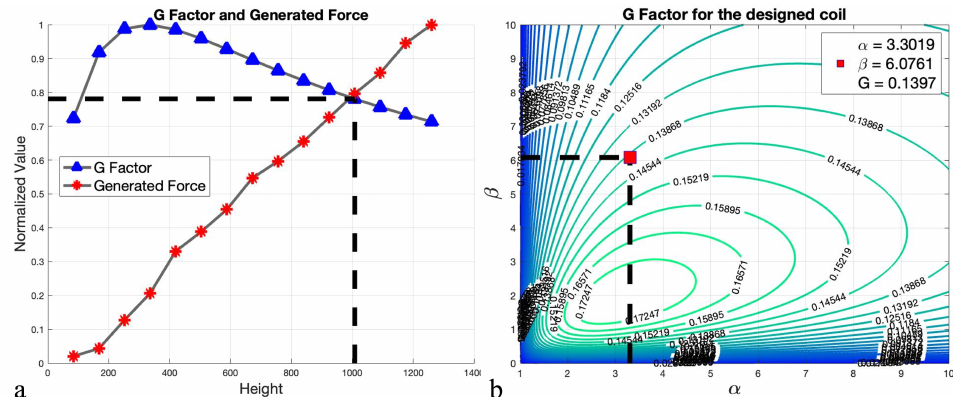
Figure 10. ( a ) Normalized values of different scenarios. ( b ) Optimum coil parameters.